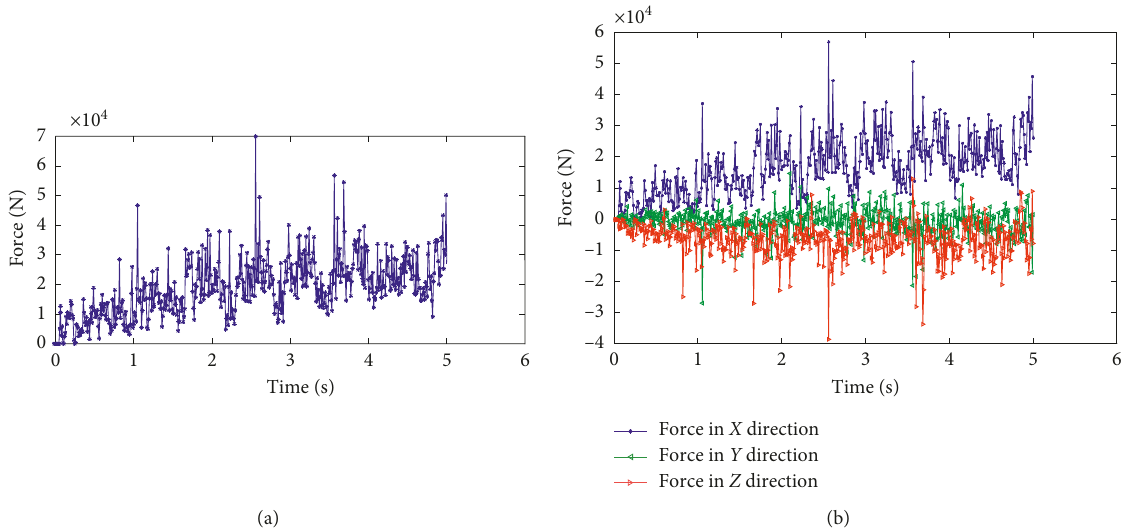
Figure 4: (a) The total force of the drum. (b) Three-directional force of the drum.